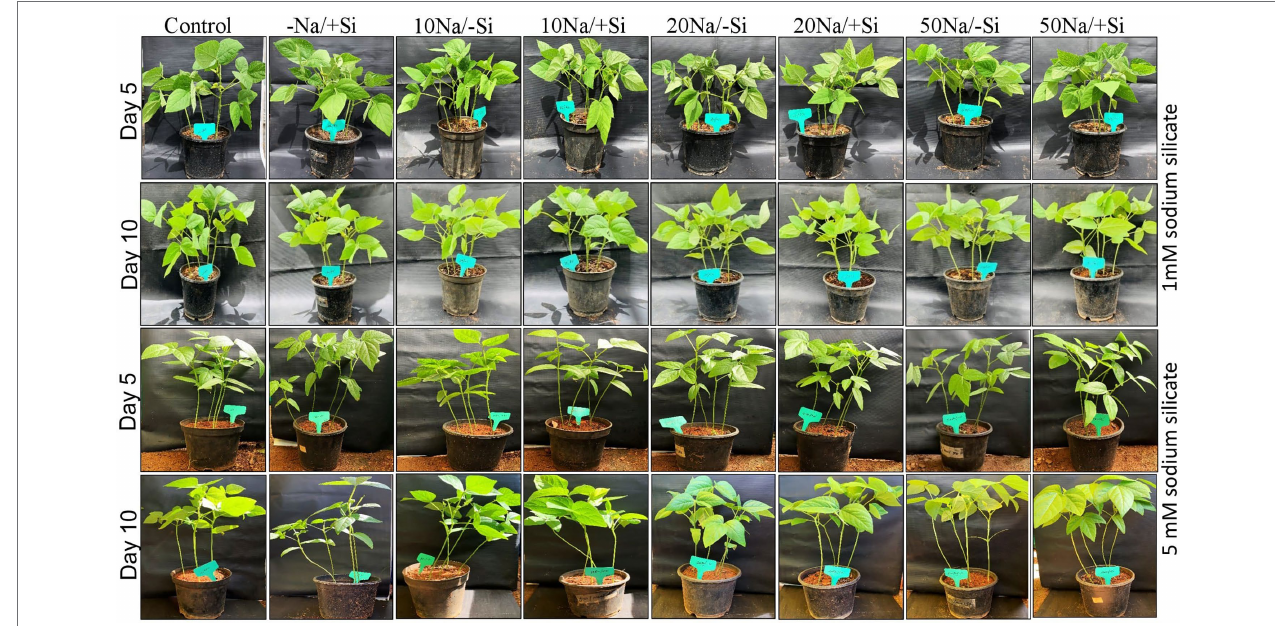
FIGURE 1 | Experimental setup of mung bean ( Vigna radiata ) under 1 mM (Si 1 ) and 5 mM (Si 2 ) Si supply and salinity stress after eight treatments: (i) control (T1),